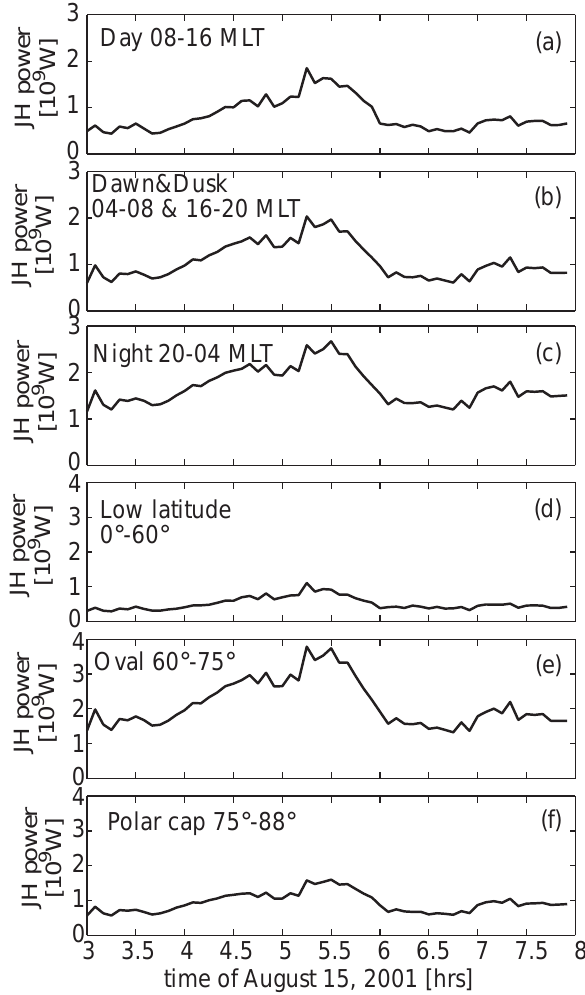
Fig. 9. Joule heating power during the April 2000 storm in (a) the dayside 08:00–16:00 MLT, (b) dawn 04:00–08:00 MLT and dusk